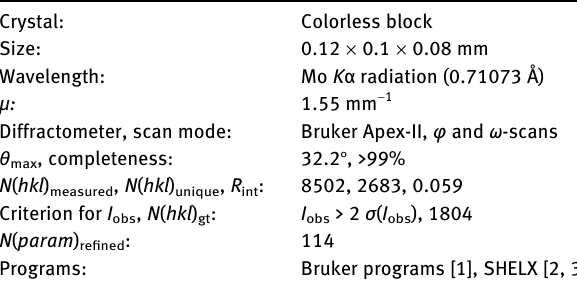
Table  : Data collection and